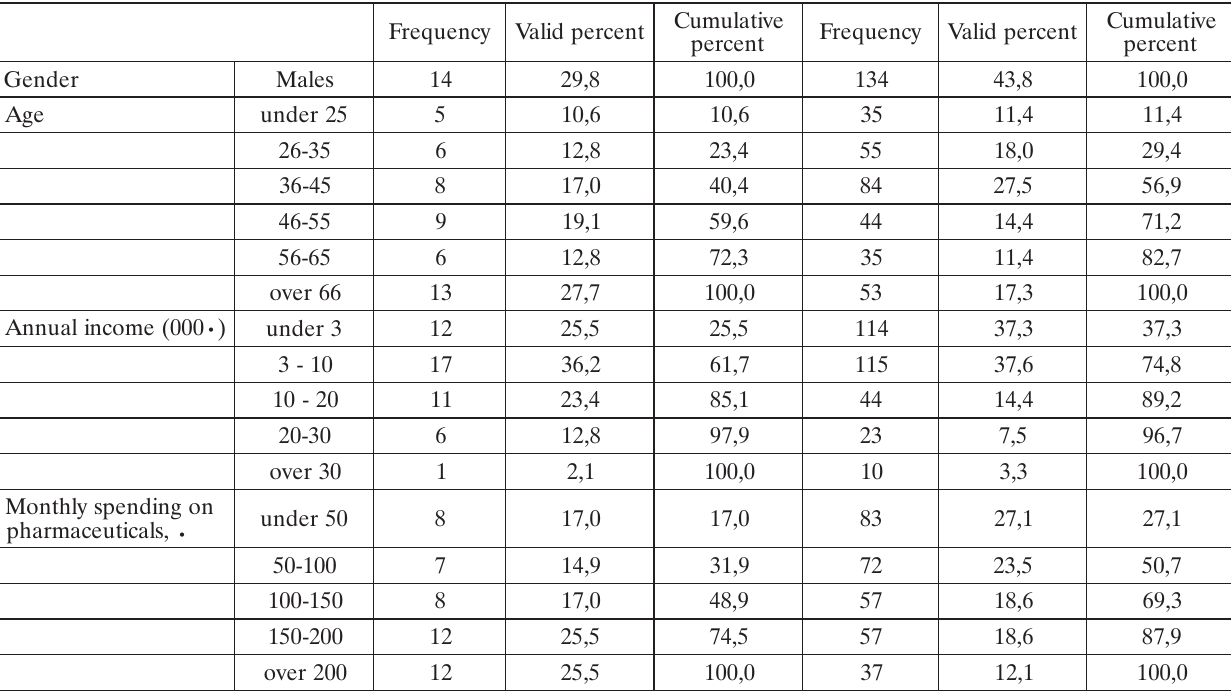
Table 6. Distribution of consumers according to noticed adverse reactions and possibility to purchase necessary drugs